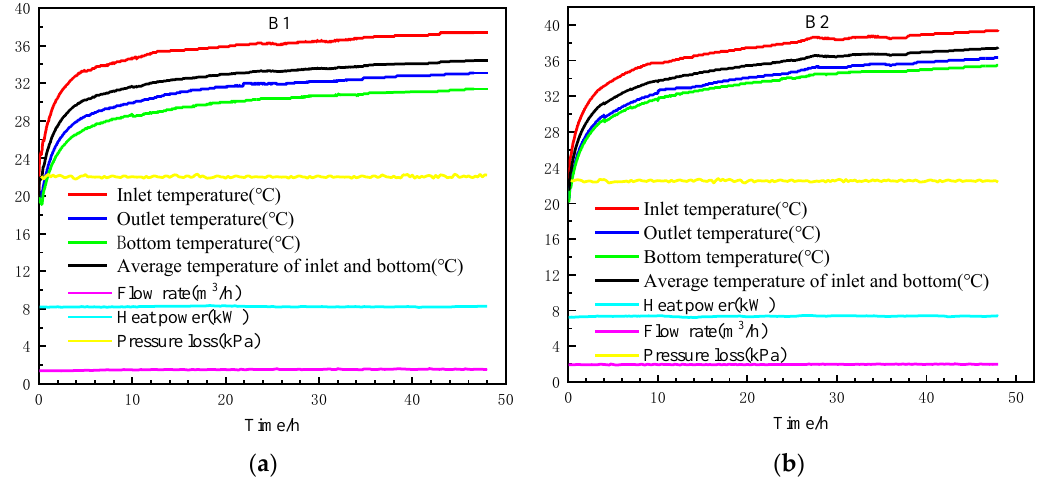
Figure 4. Improved thermal response test (ITRT) result of B1 and B2. ( a ) ITRT conditions and results of B1. ( b ) ITRT conditions and results of B2.